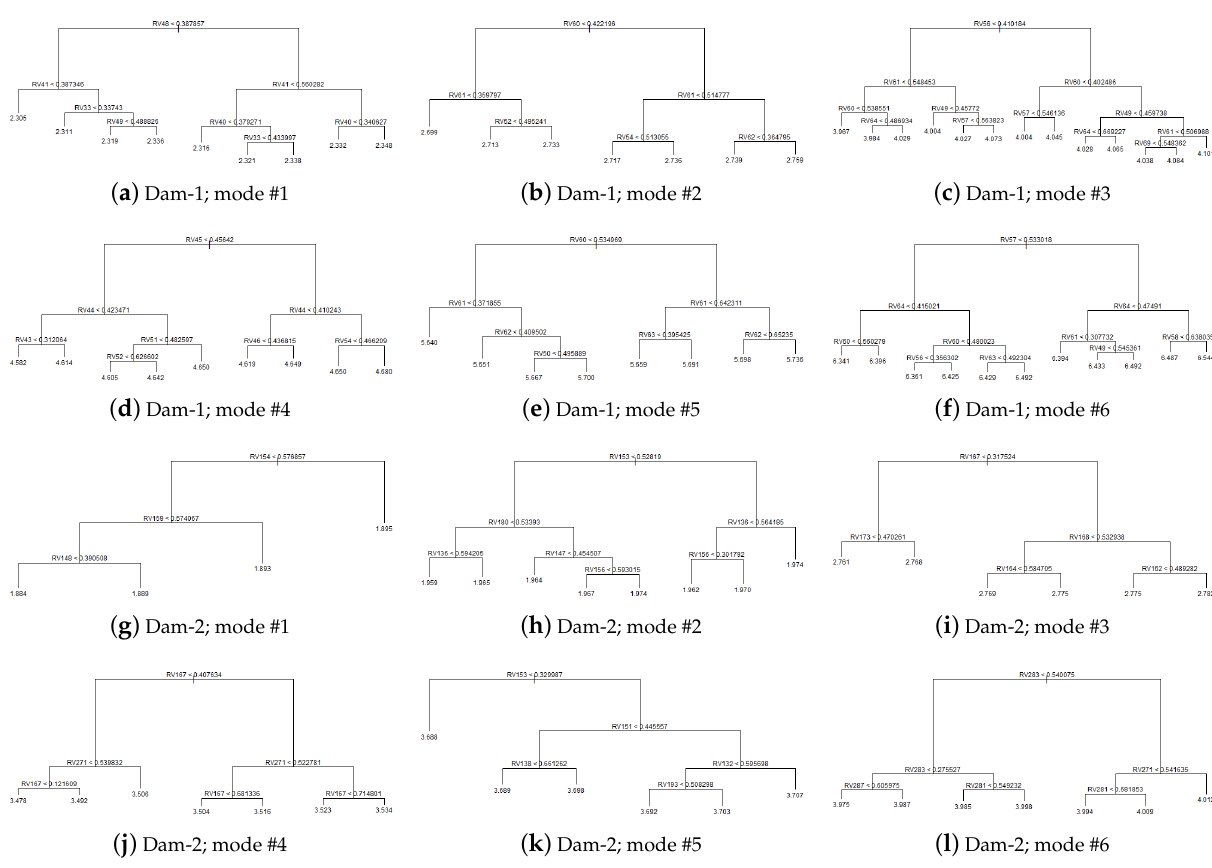
Figure A2. Regression trees to identify the important random variables (RVs) (i.e., locations) at different vibration modes in Dam-1 and